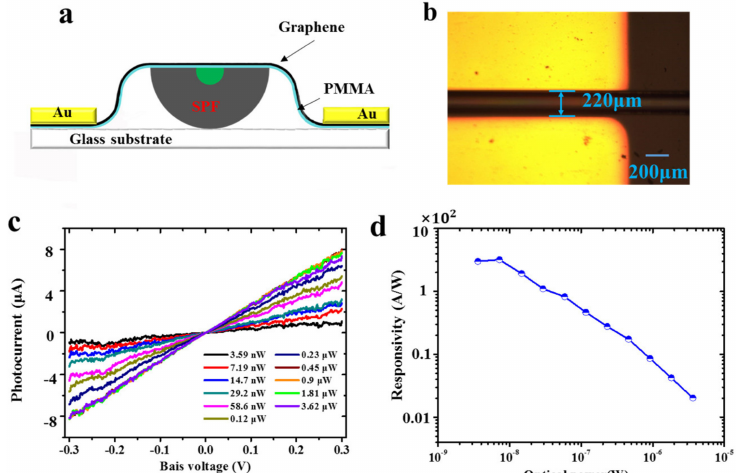
Figure A7. Structure and photoresponse of a photodetector with parallel electrodes. ( a ) A lateral view of the photodetector with parallel electrodes. ( b ) A microscope image of the parallel electrodes. ( c ) Photocurrent changing with the bias voltage for different optical power levels. ( d ) Dependence of responsivity on optical